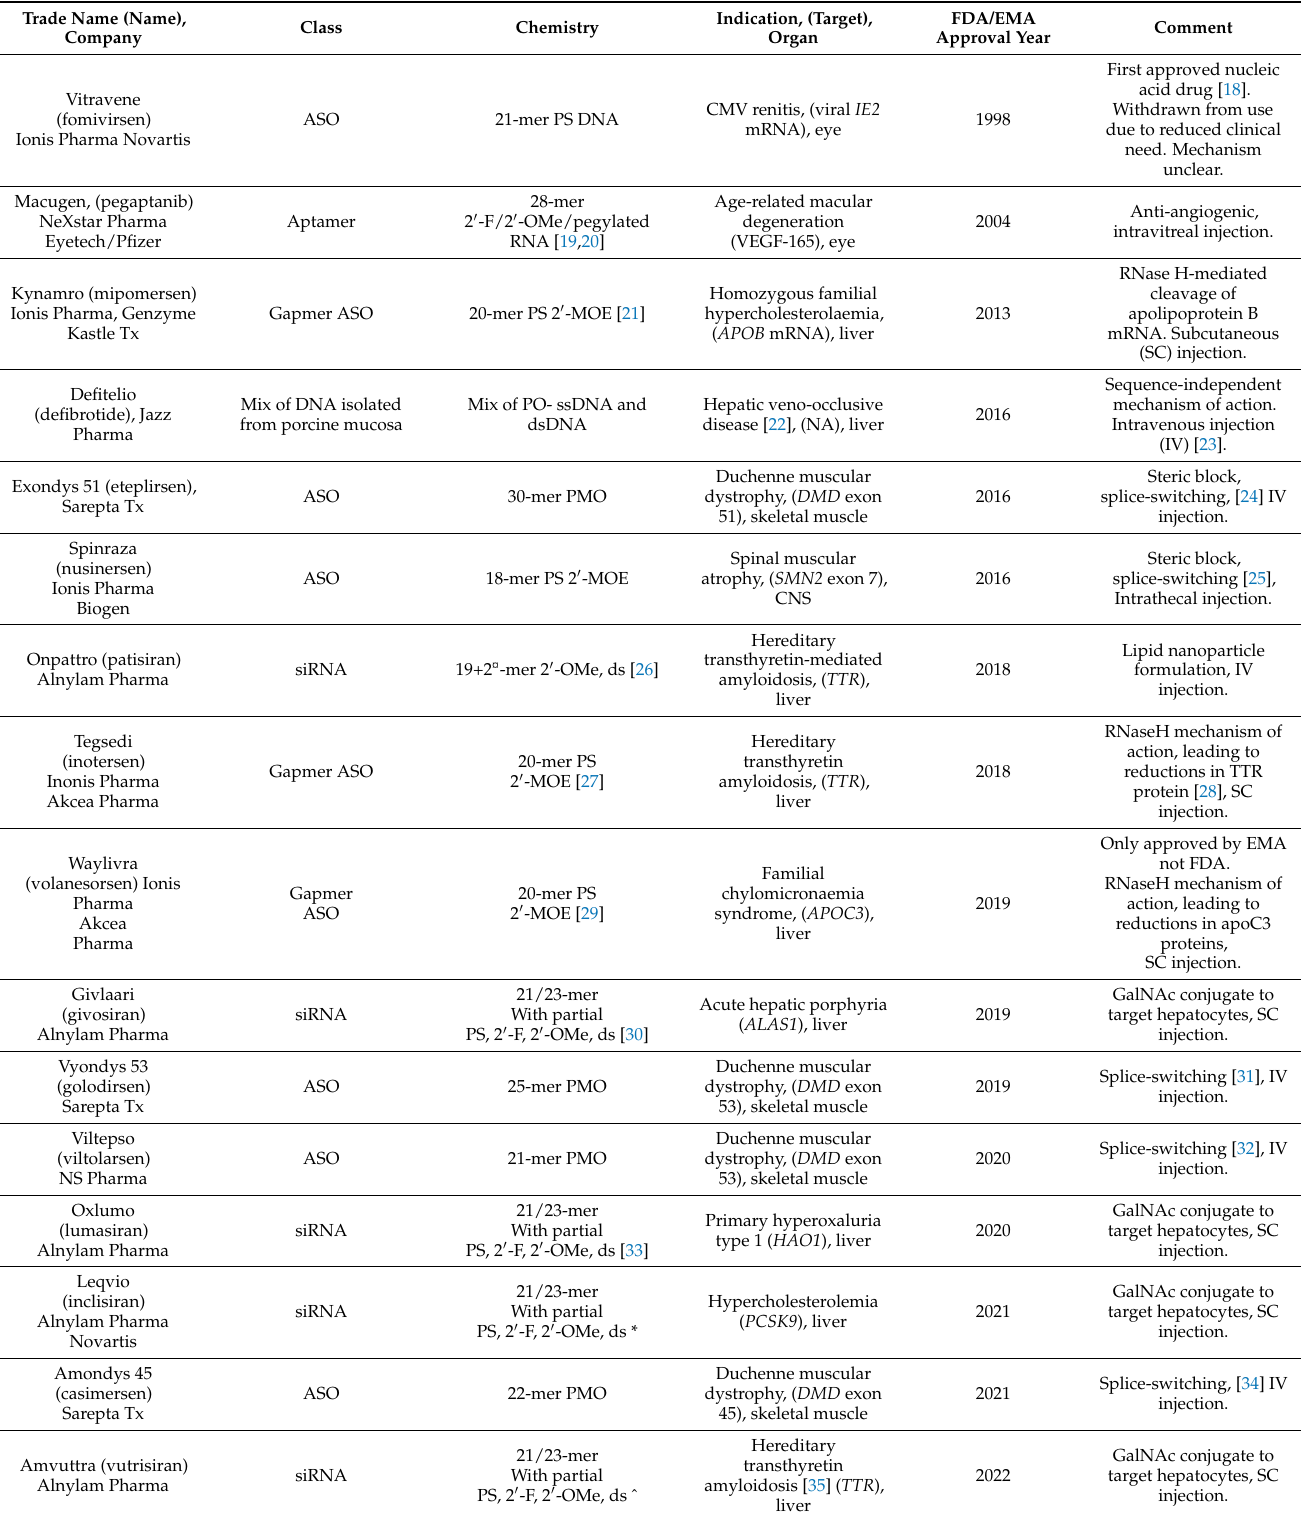
Table 1. Characteristics of clinically approved therapeutic